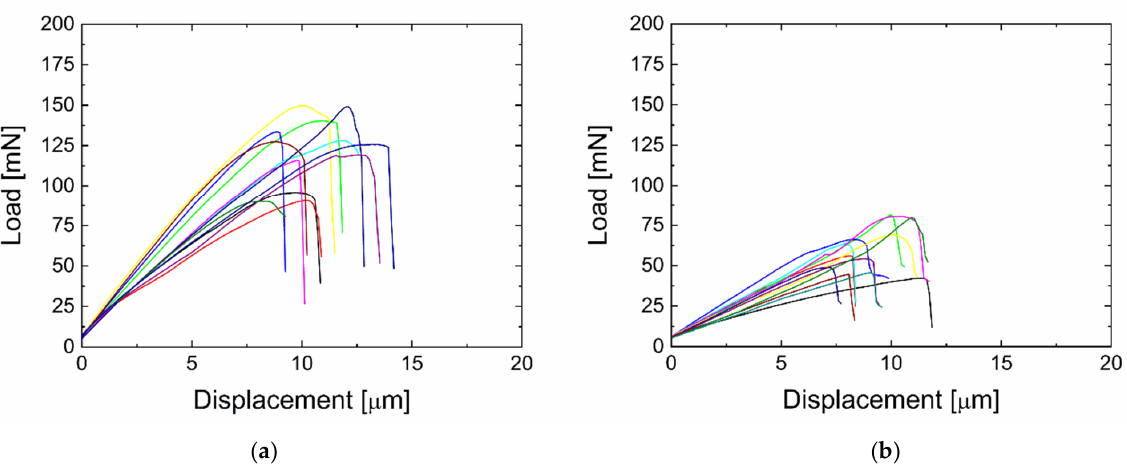
Figure 4. Load–displacement curves obtained by the push-out test for composites with plasma-nanocoated GFs using 33% O 2 in the TVS/O 2 mixture and at a power of ( a ) 2 W and ( b ) 30 W.